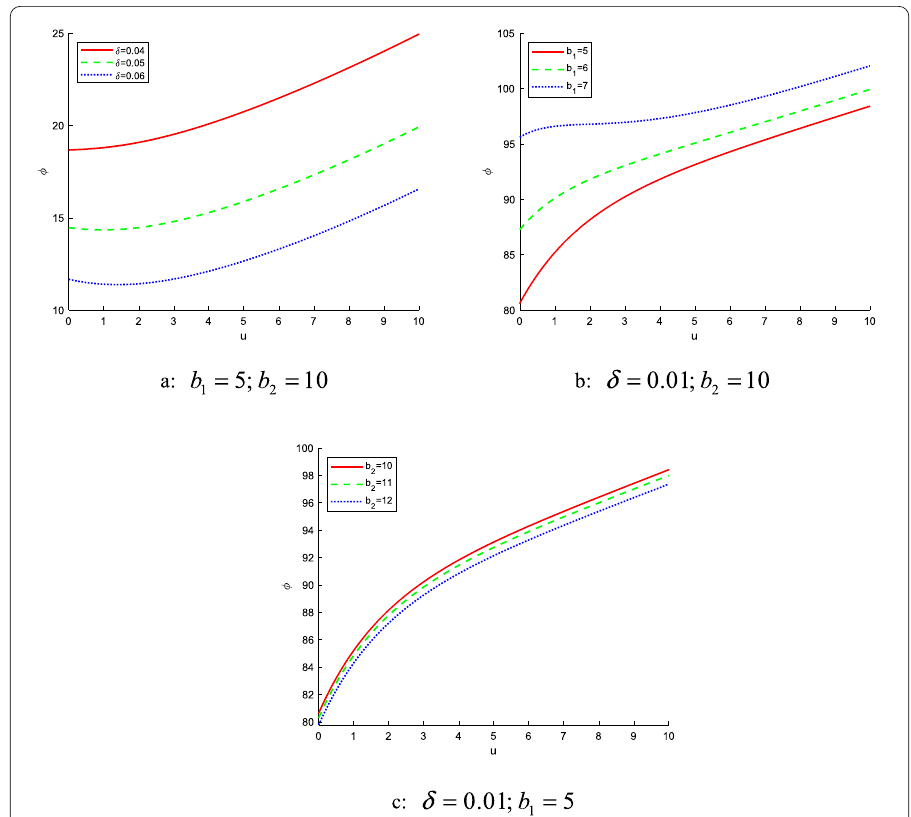
Figure 4 The expected discounted dividend payments until ruin